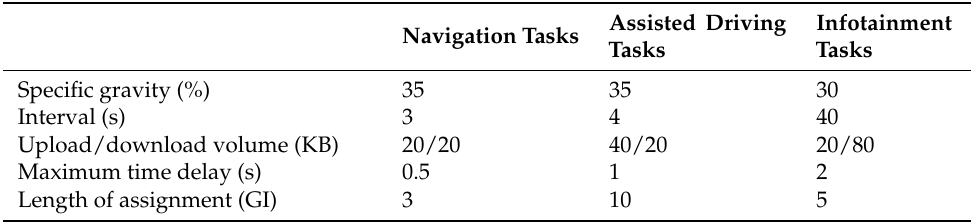
Table 2. Task parameters.